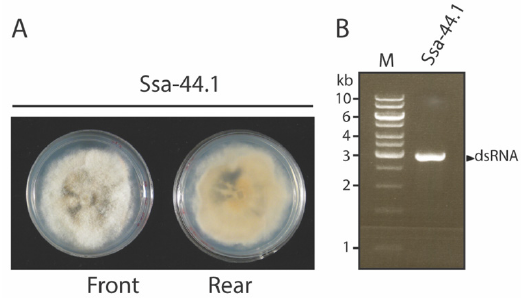
Figure 1. Colony morphology of anthracnose causing disease, C. gloeosporioides , and mycovirus dsRNA profiles. ( A ) Morphology of C. gloeosporioides strain Ssa-44.1 following 5 days incubation at 25 °C on PDA at 5 days after incubation. ( B ) Presence of mycovirus confirmed by gel electrophoresis on 1% agarose gel. Lane M, marker (GeneRuler 1 kb DNA Ladder). 3.2. Genome Organization and Phylogenetic Analysis of Mycovirus Ssa-44.1 To obtain the complete genome sequence of the suspected dsRNA mycovirus, next- generation sequencing and RACE-PCR were performed. The dsRNA of strain Ssa-44.1 is 2939 bp long, with a G + C content of 54.06%. Two ORFs were found on the coding strand of Ssa-44.1 dsRNA. ORF 1 (nt 67 to 1011) encodes a hypothetical protein containing 313 amino acids (aa), while ORF 2 (nt 1026 to 2849) encodes a 606-aa protein. A BLASTn search showed that the full-length dsRNA sequence of Ssa-44.1 was most closely related to Colle- totrichum gloeosporioides RNA virus 1 (CgRV1) genome with the identity of 82.14% and was nominated Colletotrichum gloeosporioides RNA virus 1 strain Ssa-44.1 (CgRV1-Ssa- 44.1). At the 5-and 3 ′ -termini of CgRV1-Ssa-44.1 respectively, 66 and 90 nt untranslated regions (UTRs) were found (Figure 2A). The potential secondary structure of the 5 ′ -and 3 ′ -termini was predicted using Mfold RNA structure software. The 5 ′ UTR could be folded into a stem-loop structure with a ∆ G of − 6.80 kcal/mol and the 3 ′ UTR with 90 nt was pre- dicted to form a stem-loop with a ∆ G of − 45.30 kcal/mol (Supplementary Figure S3). CgRV1-Ssa-44.1 ORF 1 encoded a hypothetical protein and exhibited 88.22% (E- value: 5 × 10 − 168 query cover: 100%) aa identity to a hypothetical protein of CgRV1 (QED88100) [28], followed by other unclassified dsRNA viruses including the capsid pro- tein encoded by Beauvaria bassiana non-segmented RNA virus 1 [34] (BbNRV1; AZT88649.1; E-value: 2 × 10 − 97 ; query cover: 100%; identity 56.37%); hypothetical protein of Penicillium janczewskii Beauveria bassiana-like virus 1 (PjBlV1) [35] (PjBlV1; ALO50135; E-value: 3 × 10 − 97 ; query cover: 100%; identity 56.05%) and hypothetical protein of Colletotrichum higginsianum non-segmented RNA virus 1 [36] (ChNRV1; YP. 009177217.1; E-value: 5 × 10 − 84 ; query cover: 81%; identity 58.37%). The protein encoded by CgRV1-Ssa-44.1 ORF 2 showed 90.19% (E-value: 0; query cover: 97%) aa identity to the CgRV1 RNA-dependent RNA polymerase (RdRp) (QED88100) [28], followed by other unclassified dsRNA viruses including Penicillium